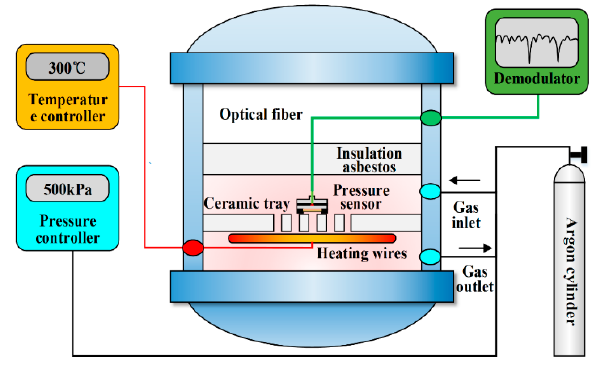
Figure 6. Schematic diagram of the experimental setup.